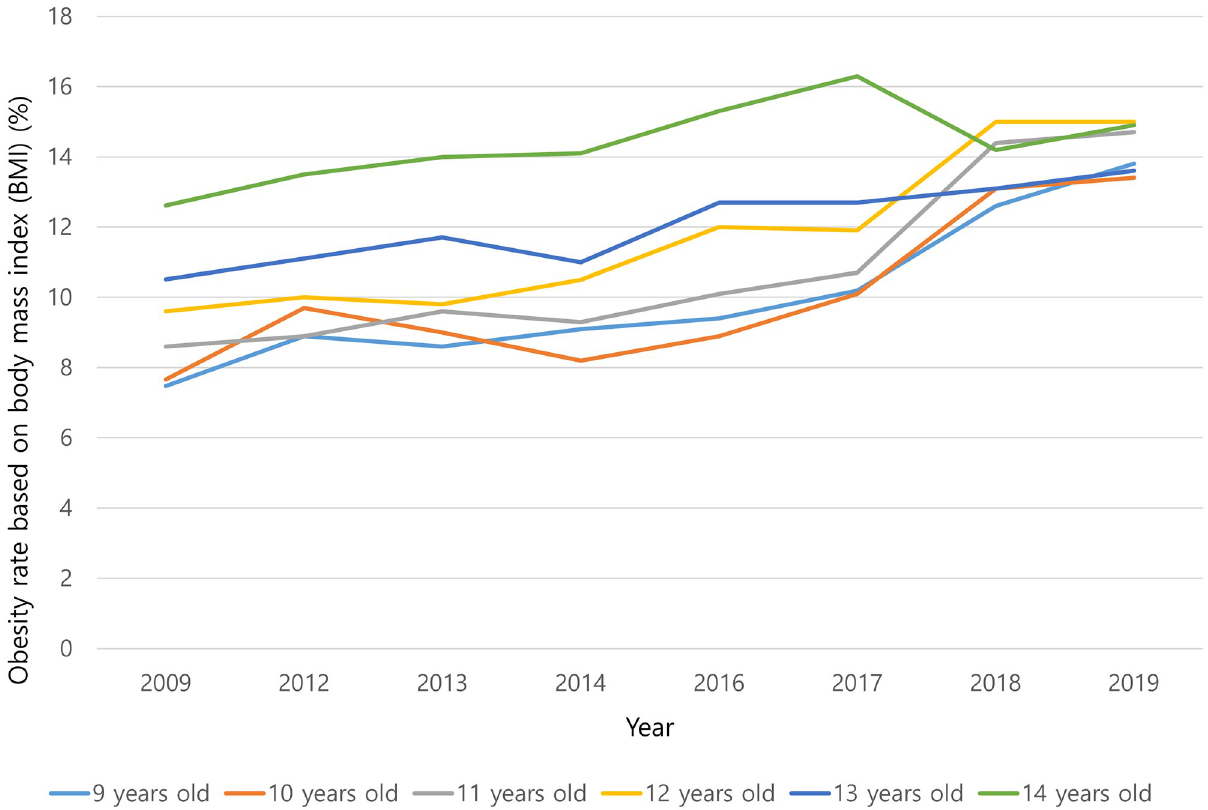
Fig 3. Annual increase in obesity rate based on body mass index (BMI) since 2009 in the Korean population aged 9–14 years. * BMI was assessed by age-specific and sex-specific percentiles and obesity was defined as a BMI above the 95th